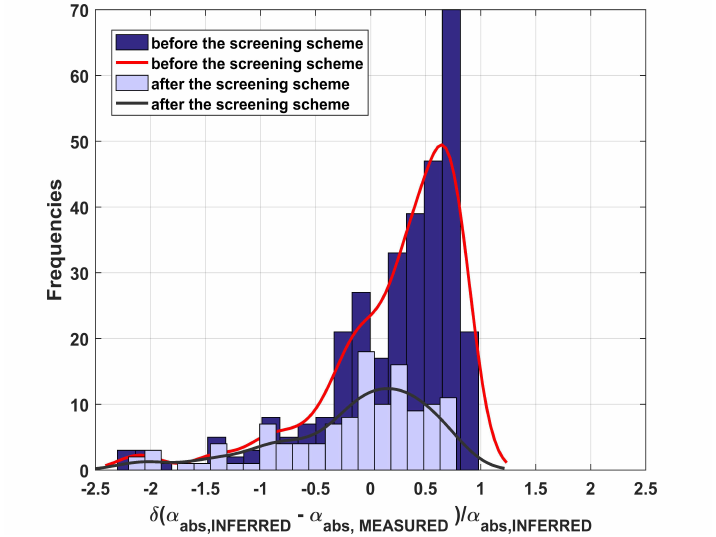
Figure 7. Histogram plot of differences between AERONET—inferred and in-situ measured surface α abs relative to AERONET—inferred α abs before (dark blue) and after (light blue) the screening scheme, with smoothing fit